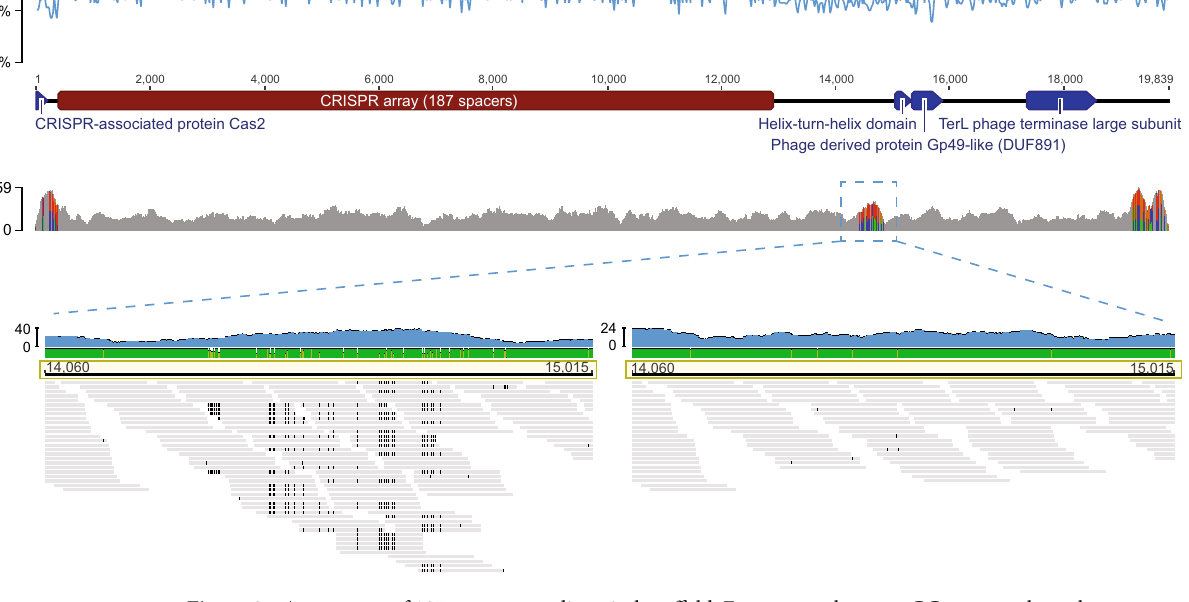
Figure 3. Assessment of 187 spacer encoding viral scaffold. From top to bottom: GC content along the length of the scaffold (total length 19,839 bp); annotation map of relevant genes; depth of read coverage and heterogeneity. The variable region between 14K-15K is marked with a blue box. Full read mapping on the left demonstrates two potential sequences for this region. On the right, the higher abundance path is shown. This image was made using Geneious 60 and IGV 63